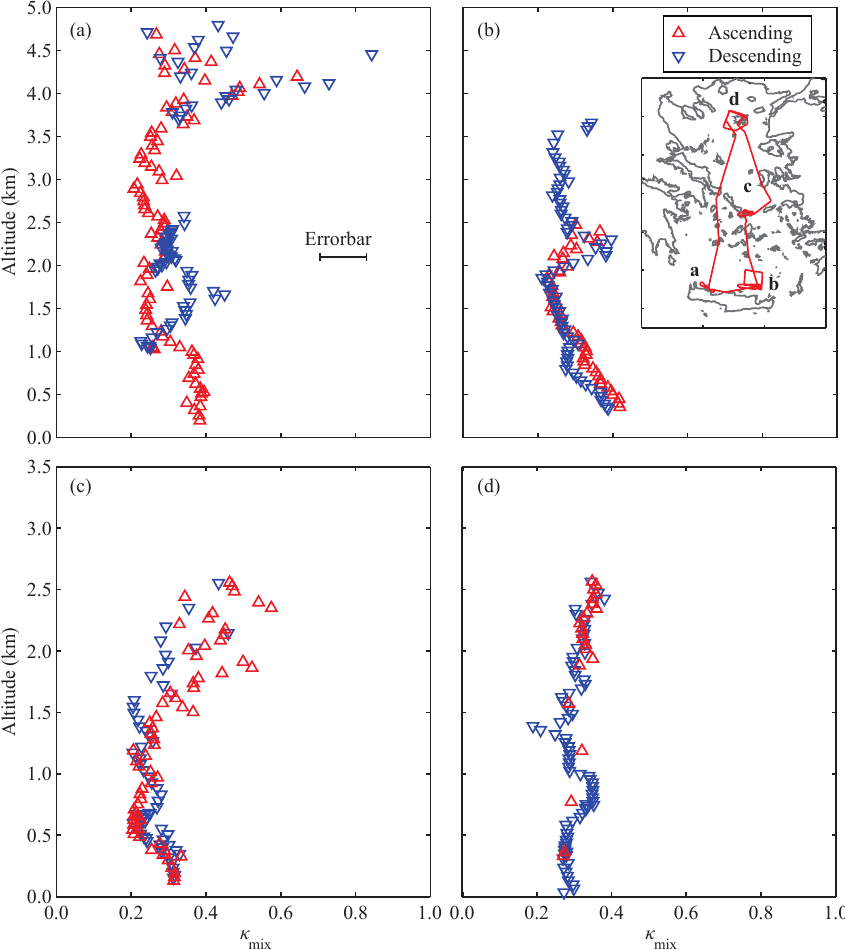
Fig. 9. Vertical profiles of the estimated hygroscopic parameters κ mix of aerosol particles observed over southwestern (a) southeastern (b) , central (c) and northern (d) Aegean Sea, during ascends (up triangles) and descends (down triangles) performed on the flight of 1 September 2011 (flight b637). The inset shows the locations corresponding to the vertical profiles of κ mix shown in the different subplots. The hy- groscopic parameters are calculated using the κ -Köhler theory (Eq. 3) and the bulk chemical composition measurements from the airborne cToF-AMS. For the calculations we assumed that the particles were internally mixed, and that all the organic species had κ org = 0 . 03 and ρ org = 1300kgm − 3 . The error bar represents the spread of the estimated κ mix values when adopting the level of uncertainty used in our closure